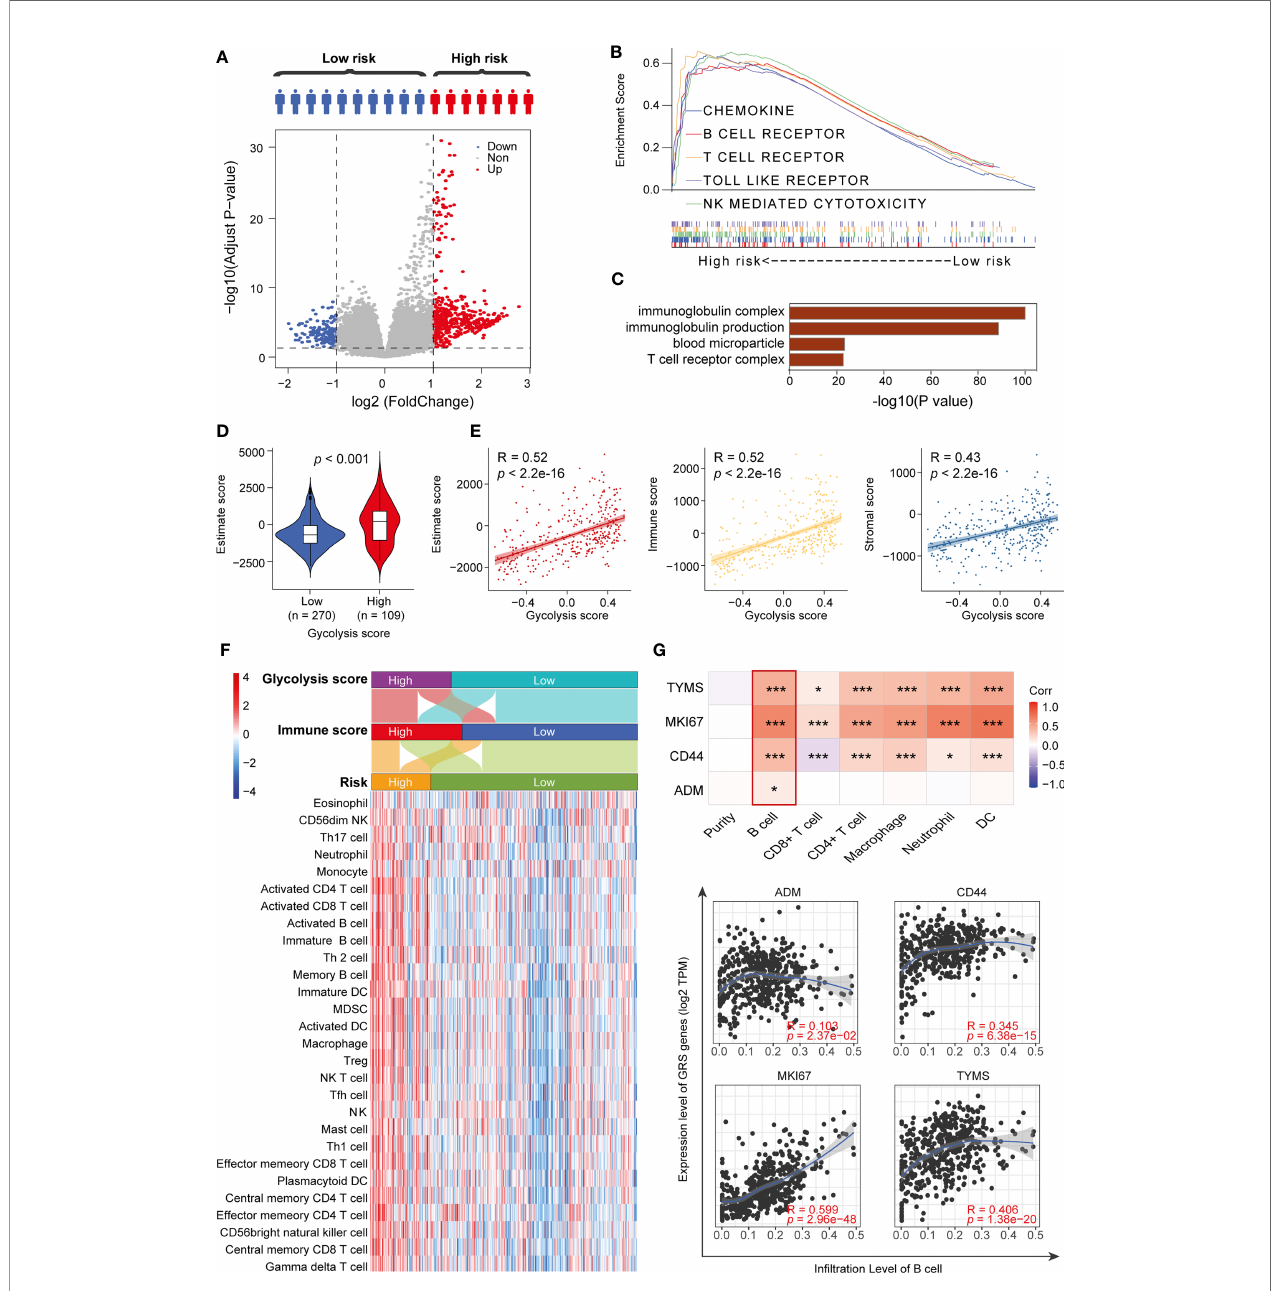
FIGURE 5 | High-risk patients exhibit immune pathway activation. (A) Volcano plot showing DEGs between high-risk and low-risk patients. (B) GSEA results for the high-risk group. (C) GO terms for upregulated DEGs. (D) Immune status scores of different risk groups. (E) Correlation analysis of glycolysis scores and immune scores. (F) ssGSEA algorithm to assess the degree of immune cell in fi ltration in different risk groups. (G) TIMER algorithm to assess the correlation between GRS and the degree of immune cell in fi ltration. *p < 0.05 and ***p <